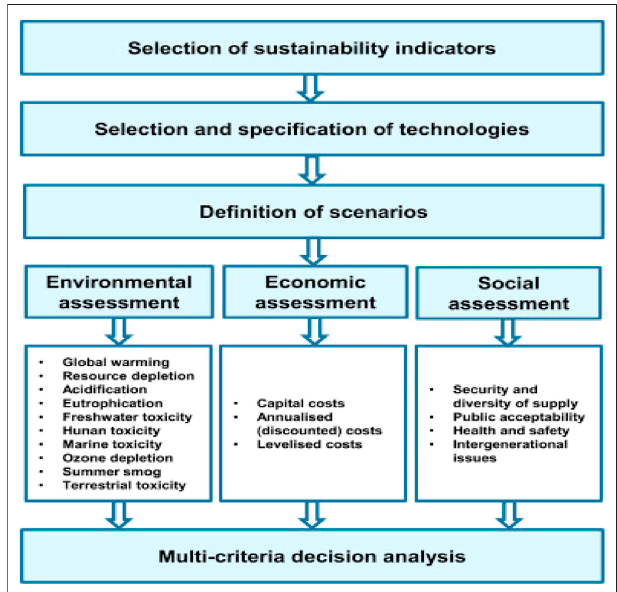
FIGURE 9 | Planning for electricity